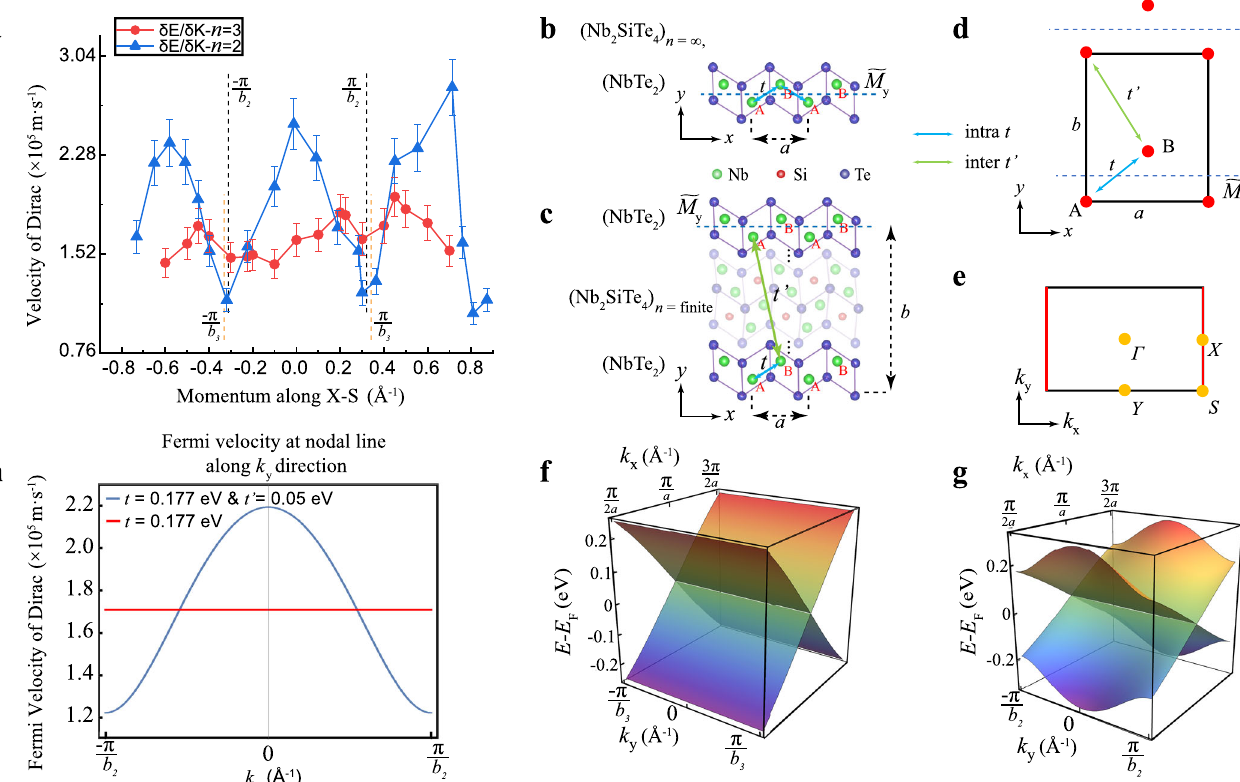
Fig. 4 Dimension-crossover and the Dirac SSH model of the Dirac fermion. a The extracted Dirac fermion velocity along X-S in NbSi x Te 2 for x = 0.43 ( n = 3) and x = 0.40 ( n = 2) samples with the theoretical BZ period appended. b Schematic of a single NbTe 2 chain. Sites A , B and intra- chain coupling t as well as glide mirror f M y are labeled. c Schematic of the NbTe 2 chains array extracted from the NbSi x Te 2 surface. NbTe 2 chain distance along the y direction is marked by b , intra-chain coupling ( t ) and inter-chain coupling ( t ’ ) are labeled. d Plot of the extracted Dirac SSH model from Fig. 4c. Two sites A and B are included in the cell, related by glide mirror f M y . The lattice constants, the intra- and interchain hopping t and t ’ are labeled. The dash line denotes the glide plane. e Corresponding BZ for the Dirac SSH model. The orange points denote the high symmetry points and red lines denote the location of nodal line at k x · a = ± π . f 1D Dirac SSH model derived dispersion with t = 0.177 eV. g 2D Dirac SSH model derived dispersion with t = 0.177 eV and t ’ = 0.05 eV. h Calculated Fermi velocity of the Dirac fermion along the k x direction and its evolution along the k y direction with t = 0.177 eV (red curve) and t = 0.177 eV, t ’ = 0.05 eV (blue